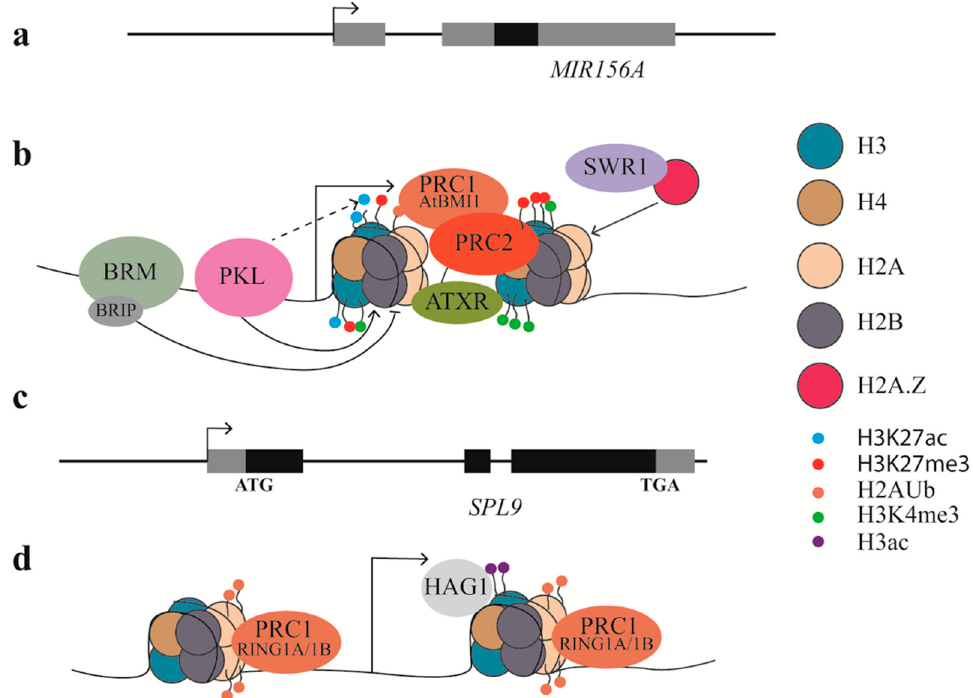
Figure 3. Epigenetic regulation of vegetative phase change. ( a , c ) Schematic diagrams of MIR156A and SPL9 . Solid black boxes represent stem-loop structure of MIR156A or exons of SPL9 , solid grey boxes represent transcripts that were not functional or untranslated. Arrow heads indicate transcription start site.( b ) Epigenetic regulation of MIR156A . The formation of nucelsomes after the transcription start site prevents transcription. Chemical modifications on the tails of the core histones can either result in further condensation of the chromatin and gene silencing or relaxation of the chromatin and transcription. PKL facilitates the formation of a nucleosome after the transcription start site, while BRM prevents the formation of a nucleosome. PKL potentially interacts with other factors to remove acetylation at H3K27, allowing methylation at H3K27. PRC2 facilitates H3K27me3 directly while PRC1 (AtBMI1) facilitates ubiquitination (Ub) of H2A and H3K27me3. SWR1 complex facilitates the exchange of H2A to H2A.Z, which favors methylation at H3K4. ATXR proteins directly deposit H3K4me3. ( d ) Epigenetic regulation of SPL9 . PRC1 (RING1A / 1B) facilitates Ub of H2A at SPL9, while HAG1 facilitates acetylation of H3 at SPL9